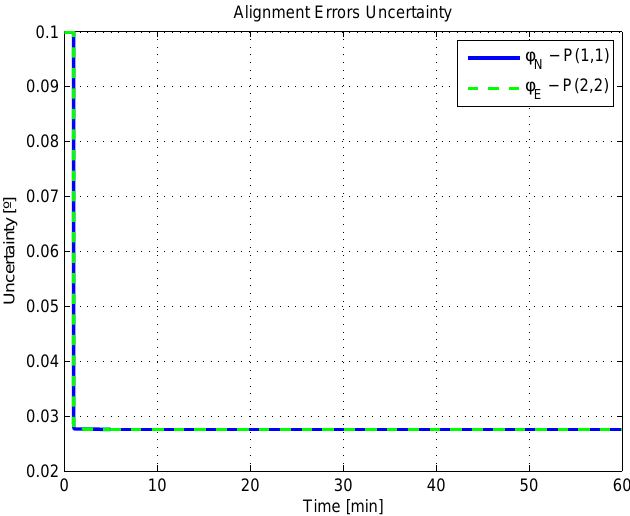
Figure 1. Alignment errors uncertainty in the simulated test.